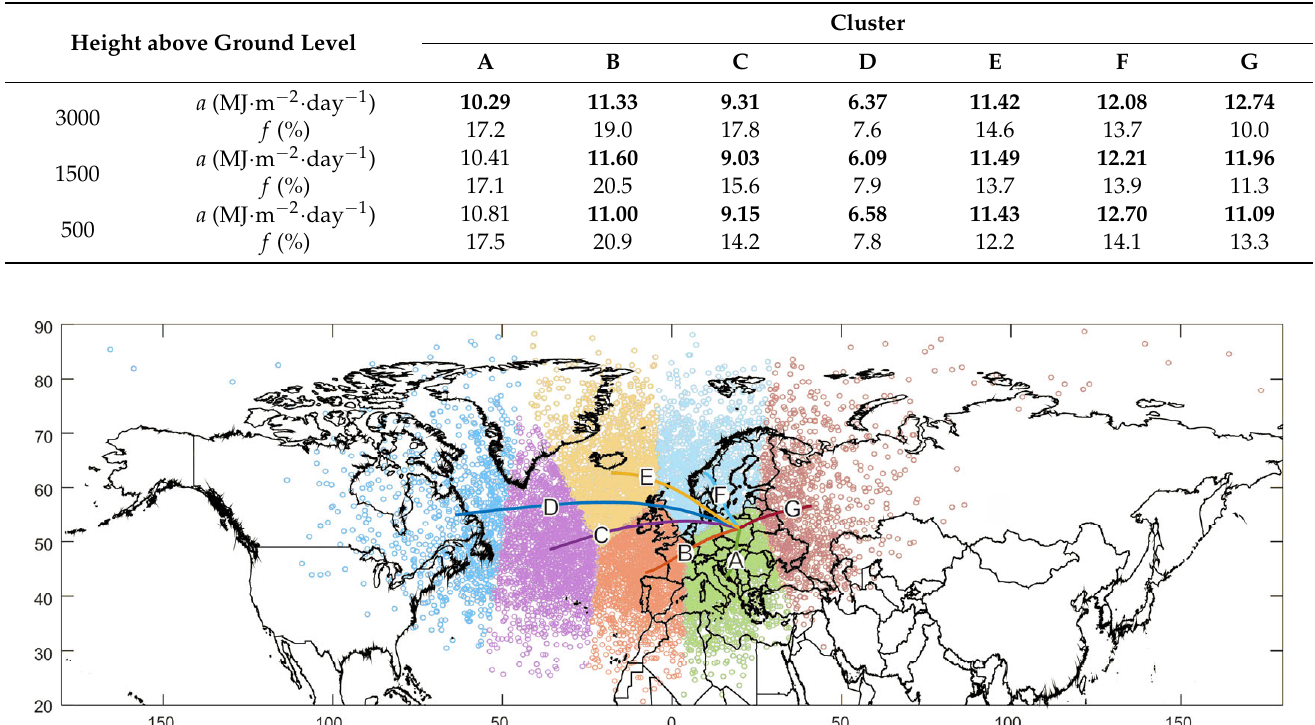
Table 1. The average daily sum of GSR, a (MJ · m-2 · day-1), over Poland during air inflow from individual clusters and the frequency, f (%), of air inflow from individual clusters during the period 1986–2015. Values that are statistically significantly different from the average daily sum in the multi-year period 1986–2015 are in bold type ( α = 0.05). The letters indicating the clusters correspond to Figure 1.